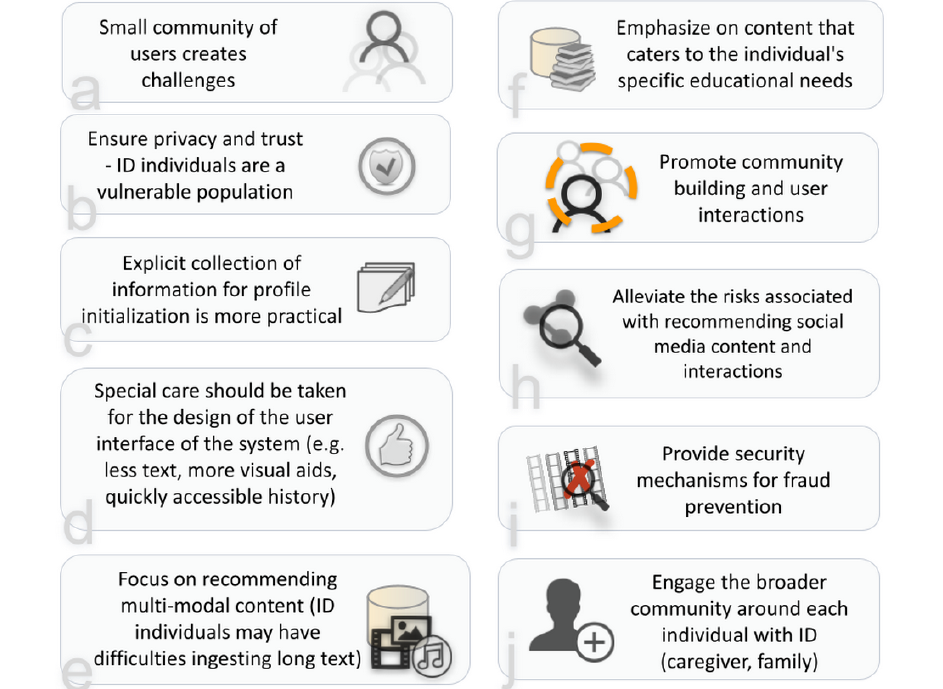
Figure 3. Infographic of the specific features that a content recommendation system targeted to individuals with ID must pay attention